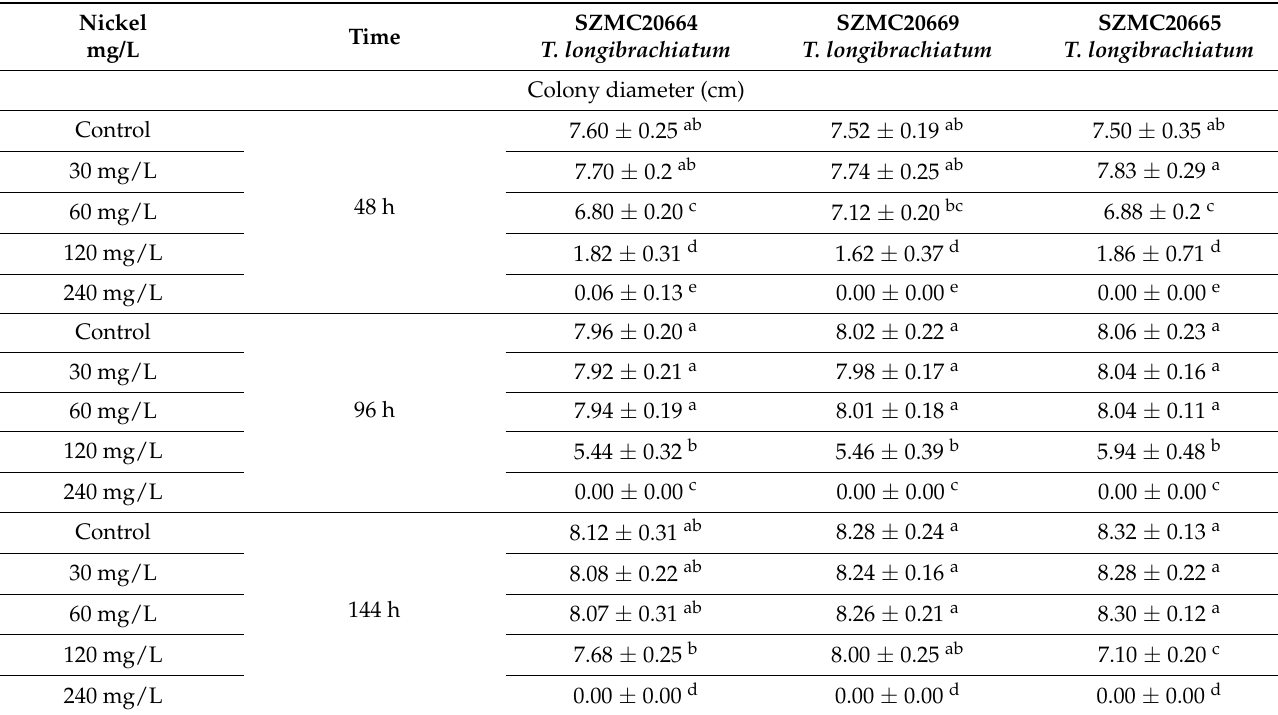
Table 3. Colony diameter of T. longibrachiatum SZMC 20664, SZMC 20665, and SZMC 20669 grown on different nickel concentrations. Different letters (a, b, c, d, e) indicate statistically significant differences according to Tukey’s